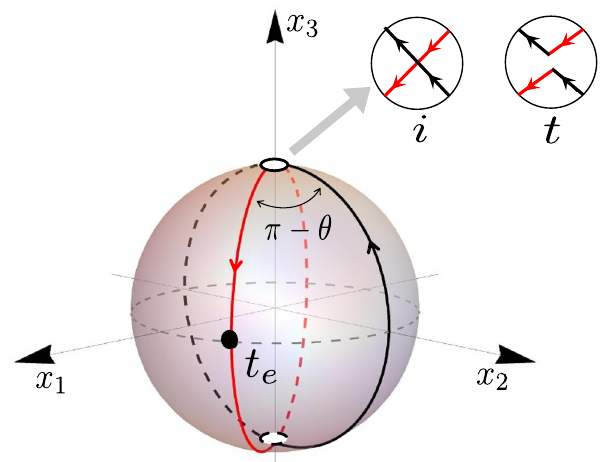
Figure 14 . Intersecting lines mapped onto S 2 . The black and the red lines denote W 1 and W 2 respectively. On S 2 , the con(cid:12)guration contains two intersections, one at the north pole and the other at the south pole. At each intersection (denoted by white circles), one can make either of